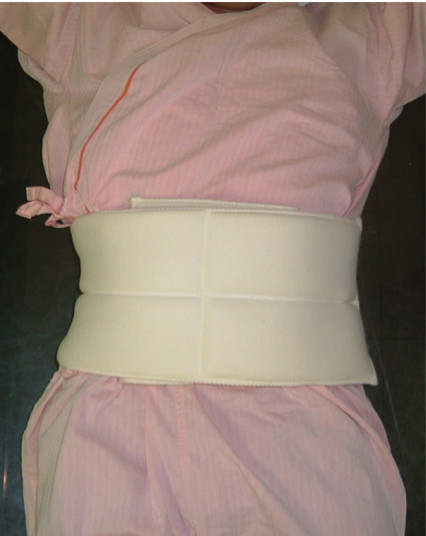
The 20-cm-wide BELT. The 20-cm-wide BELT was wrapped tightly around the patient's abdomen during end expiration to suppress diaphragmtic motion.